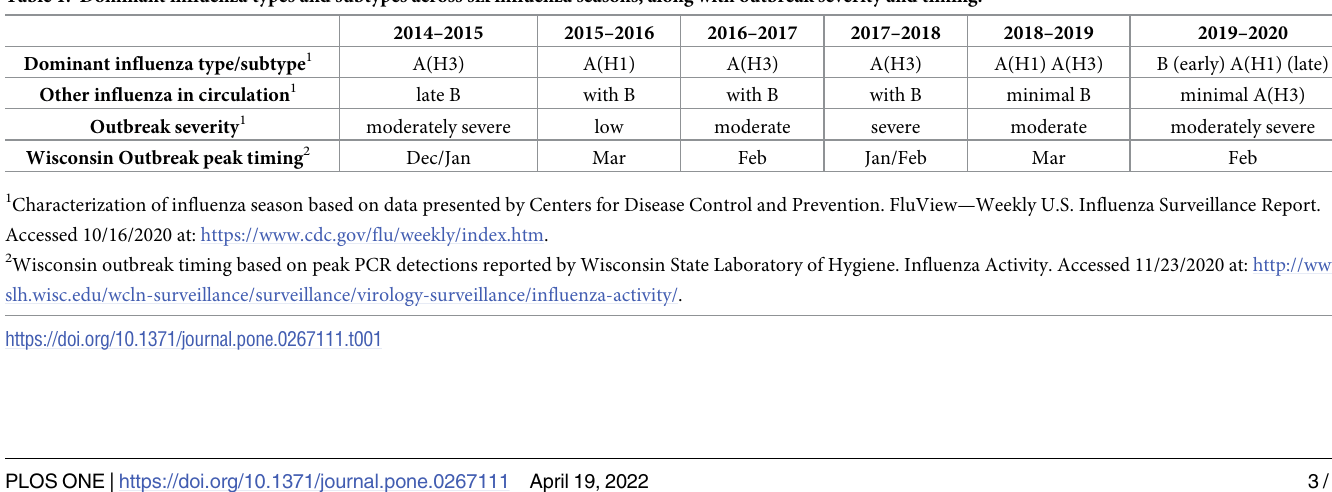
Table 1. Dominant influenza types and subtypes across six influenza seasons, along with outbreak severity and